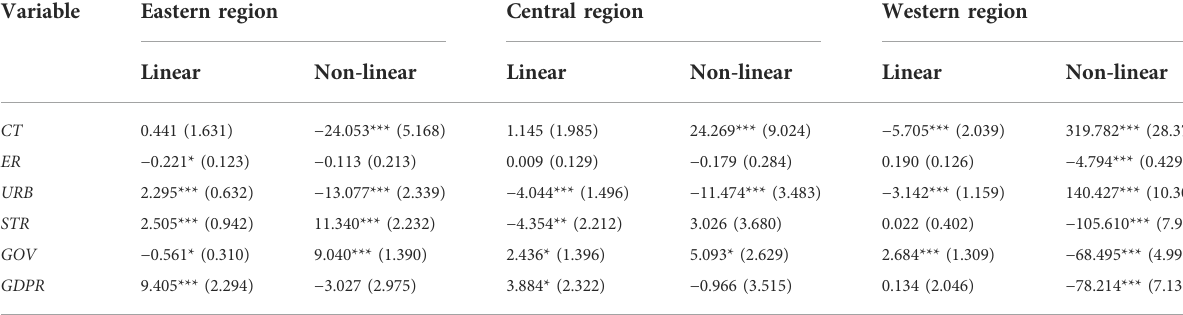
TABLE 7 Estimation results of PSTR model at sub-regional